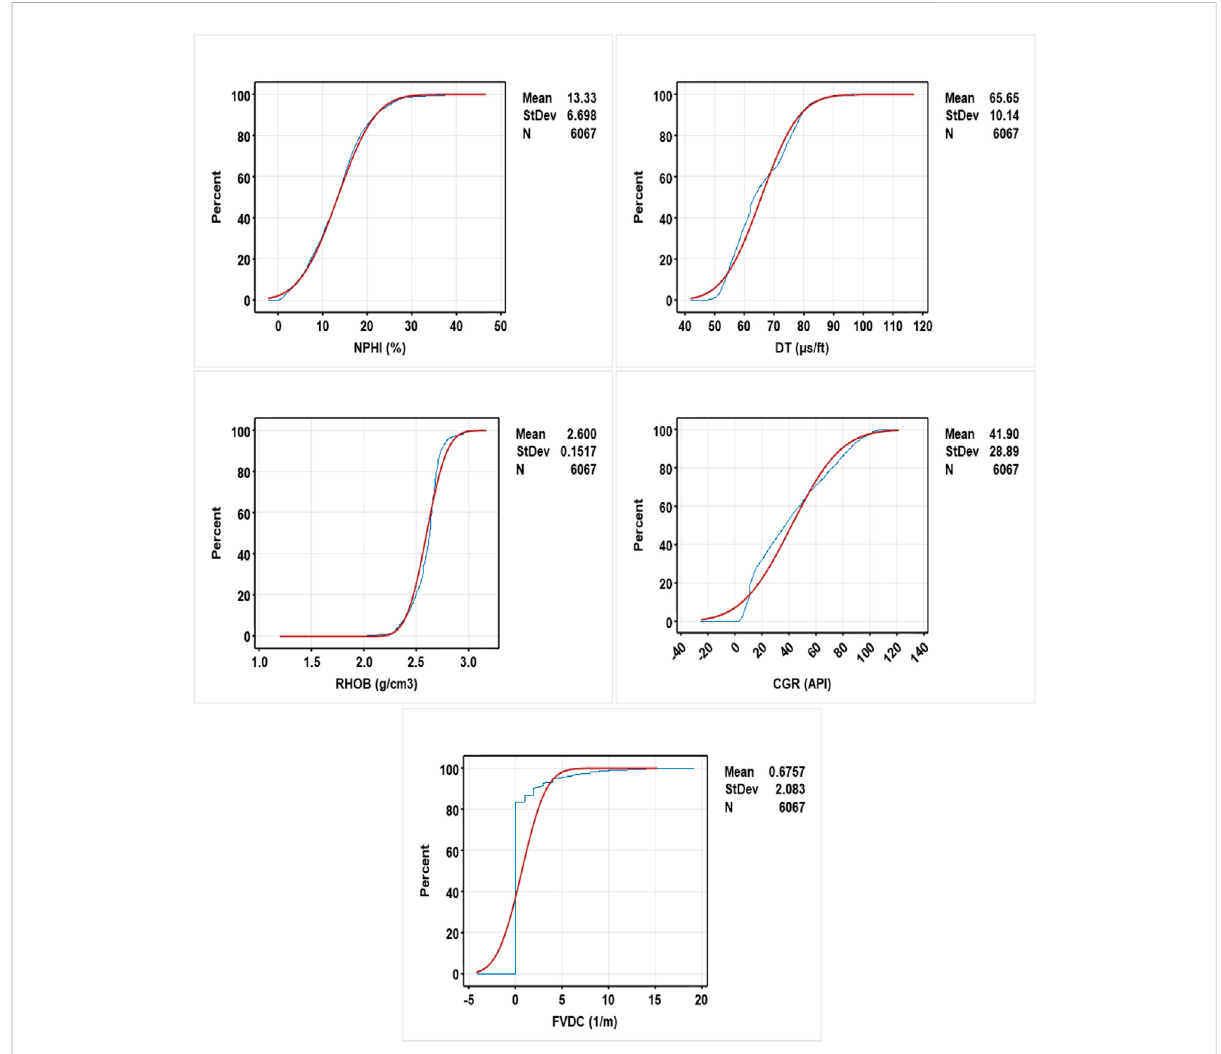
FIGURE 10 Schematicofthecumulativedistributionfunction(CDF)todescription fi veinput/outputvariablesdataset.Thevariableis:NPHI;DT;RHOB;CGR and FVDC. In this fi gure, the blue and red line an input variable and standard deviation